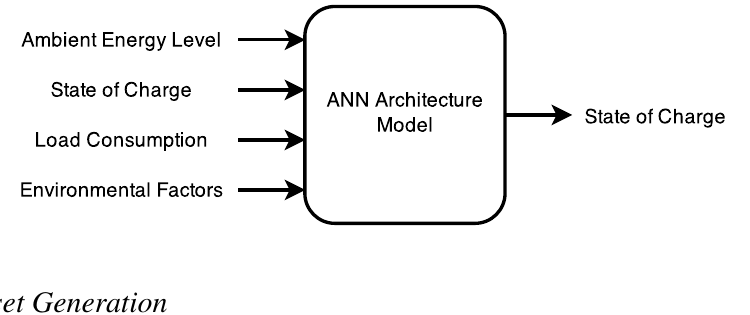
Figure 3. Overview of the state-of-charge modeling with artificial neural